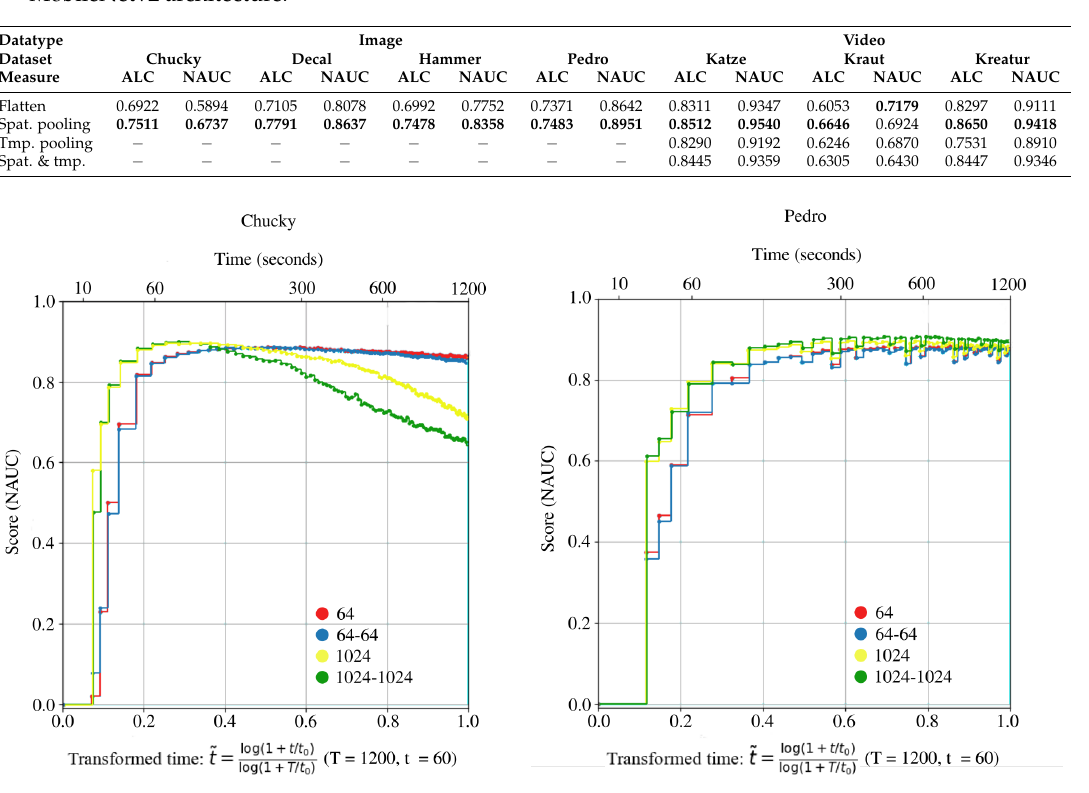
Figure 4. Vision: Learning curves as function of training time for MobileNetV2 with varying layout of the fully connected classifier layer(s): 1 layer with 64 neurons (1 × 64, red), 2 × 64 (blue), 1 × 1024 (yellow) and 2 × 1024 (green), shown for image datasets Chucky ( left ) and Pedro ( right